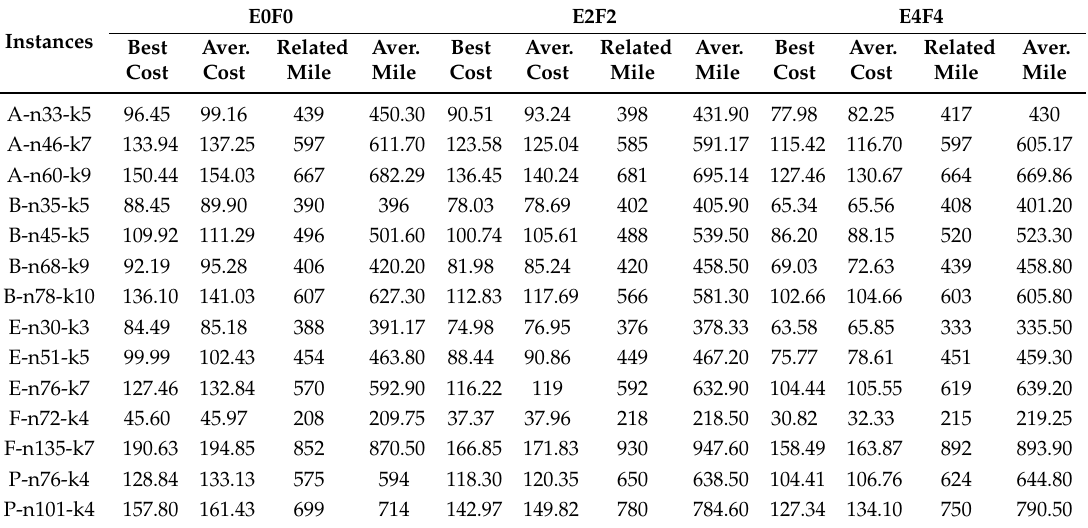
Table 2. Testing results of HMA_SVND for different